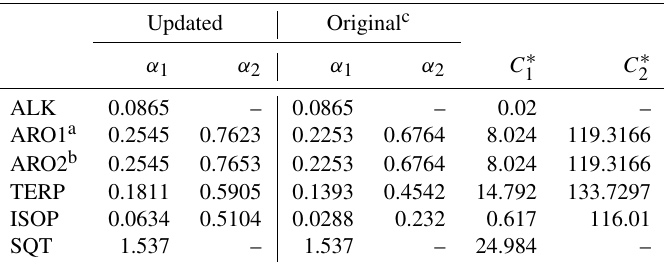
Table 1. Updated aerosol mass yields used in this study that account for the wall-loss using scaling factors based on Zhang et al. (2014). Saturation concentrations ( C ∗ ) for each product were also listed.